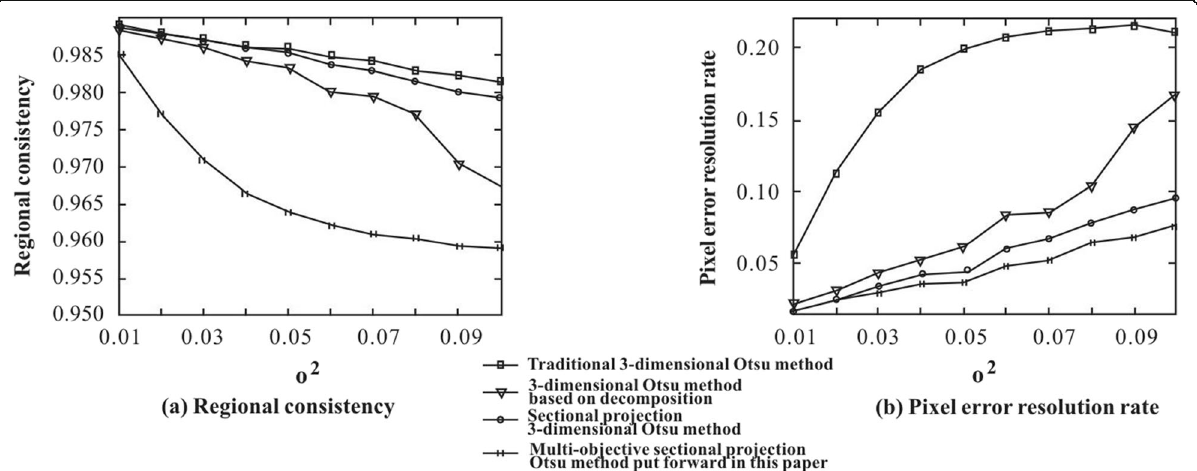
Fig. 10 Variation curve of the regional consistency and pixel error resolution rate by cameraman